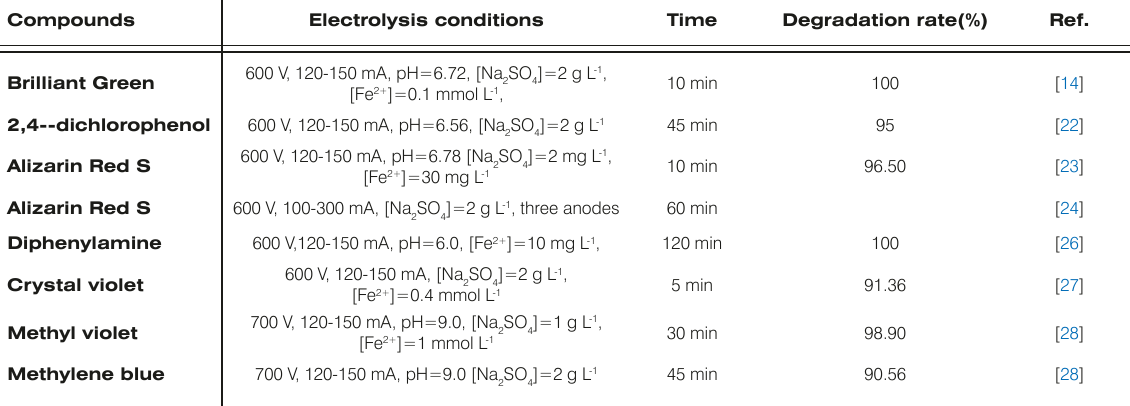
Table 1. Use of GDEP degradation of organic substances. Compounds